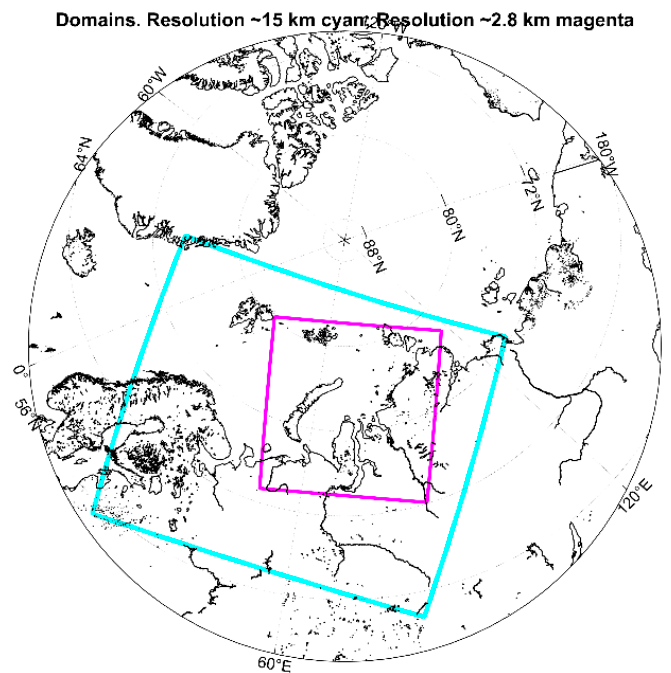
Figure 1. Map of modeling domain boundaries. The base domain is cyan, and the nested domain is magenta.